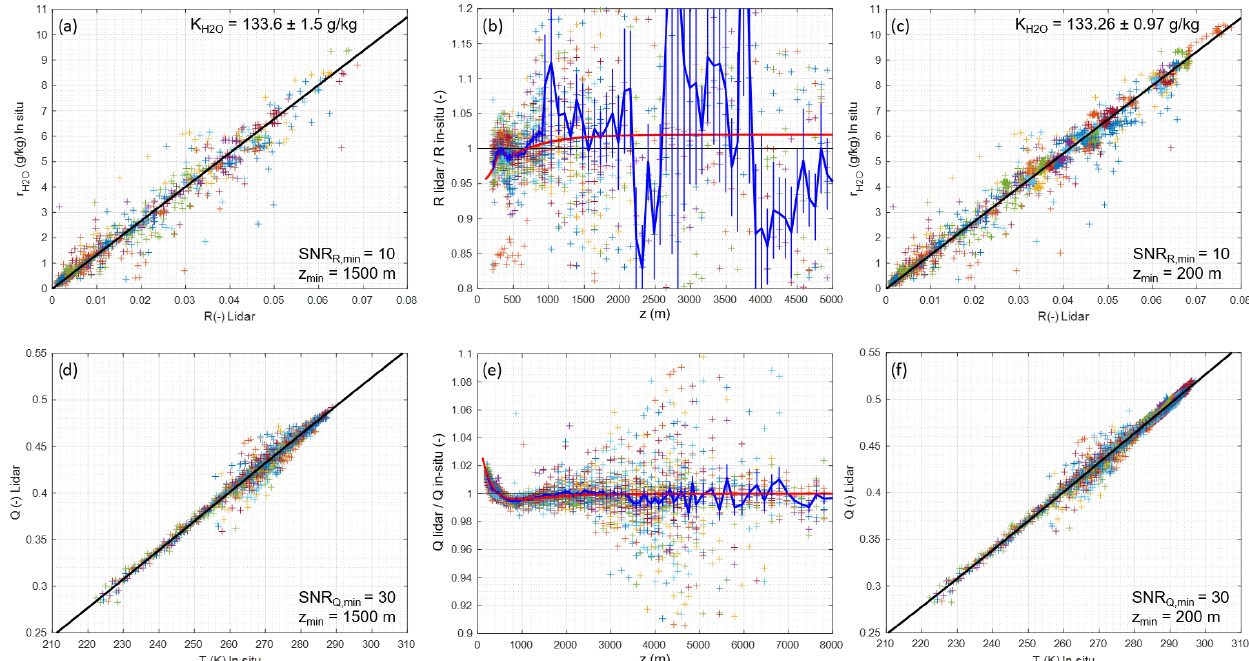
Figure 12. Results of calibration on 12 nighttime and 24 daytime radiosoundings launched from Trappes between 20 May and 2 June 2020 for WVMR (a–c) and temperature (d–f) , in three steps: calibration on measurements above 1500m (a, d) with samples as crosses (one color per radiosonde) and calibration curve in black; residual overlap ratio estimation (b, e) with samples as crosses, mean ratio in blue, random error on mean ratio as vertical bars, and model in red; and calibration on all results (c, f) . Daytime samples are limited to SNRs above 10 for R (cid:48) (WVMR) and 30 for Q (cid:48) (temperature).